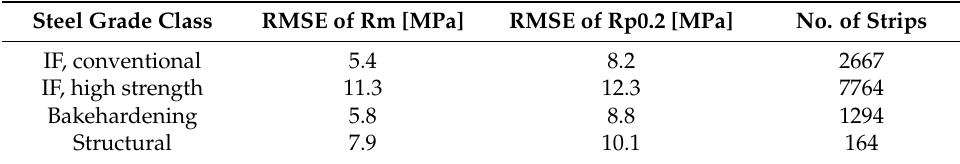
Table 6. Steel grade classes and calibration results.